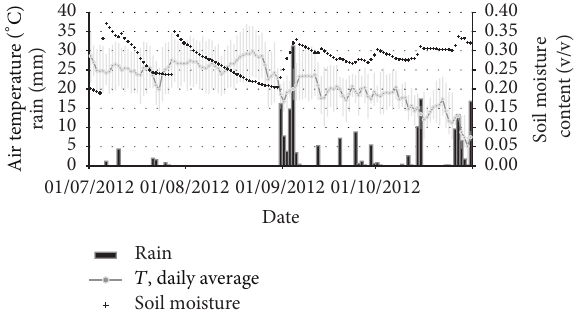
Figure 2: Meteorological conditions at the NT site. Data shown are daily averages of air temperature ( ∘ C), total daily rain (mm), and average soil moisture content (volumetric ratio: m 3 of water per m 3 of soil). The grayed area around the temperature line indicates the daily maxima and min